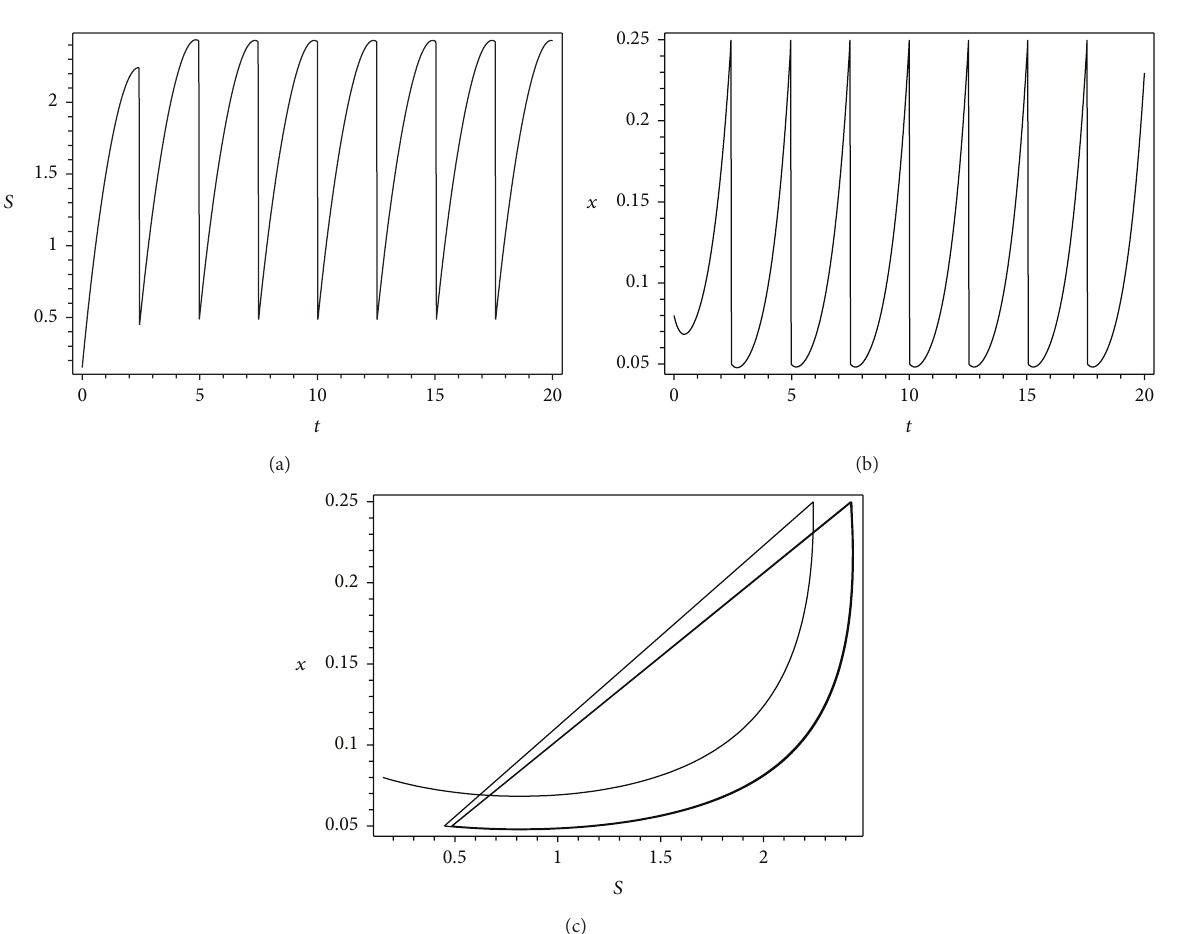
periodic. Figure 6 is the time series and phase portrait when 𝑏 = 0.8 , ℎ = 0.25 < 𝑆 ∗ , 𝑆